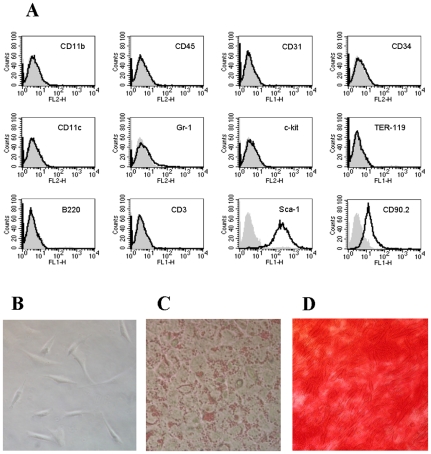
Characterization of bone marrow-derived mesenchymal stromal cells (MSC).MSC were isolated from bone marrow of adult C57BL/6J and cultured using standard protocols. (A) Analysis of the phenotype of MSC by flow cytometry. Grey histograms represent isotype controls (B) Morphology of MSC. (C) Culture of MSC in adipocyte-differentiation media showing cells containing drops of fat revealed by Oil Red O. (D) Culture of MSC in osteogenic-differentiation media showing the formation of calcium containing precipitates stained by Alizarin Red S. A representative experiment is shown.